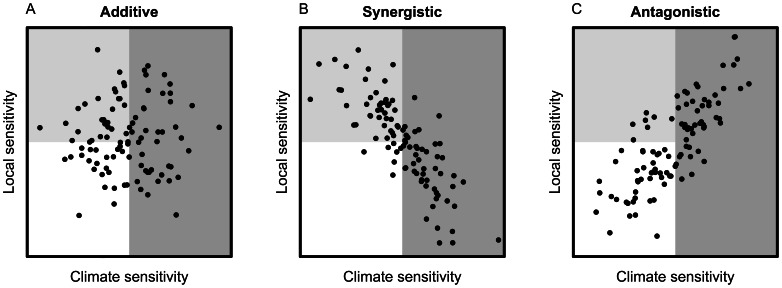
Co-tolerance of species to both climate and local stressors for three types of interactions.Species tolerances were generated randomly (nominal scales) for an additive interaction (random co-tolerance, ρ = 0), a synergistic interaction (negative co-tolerance, ρ = −0.8), and an antagonistic interaction (positive co-tolerance, ρ = 0.8). Each point represents the tolerances of a single species to the two stressors. Species in the dark grey region will be threatened by climate change stress, the local stressor will additionally affect species in the light grey region. Species in the white region will be unaffected by either stressor. The most species will be lost with a synergism and the least with an antagonism [3].